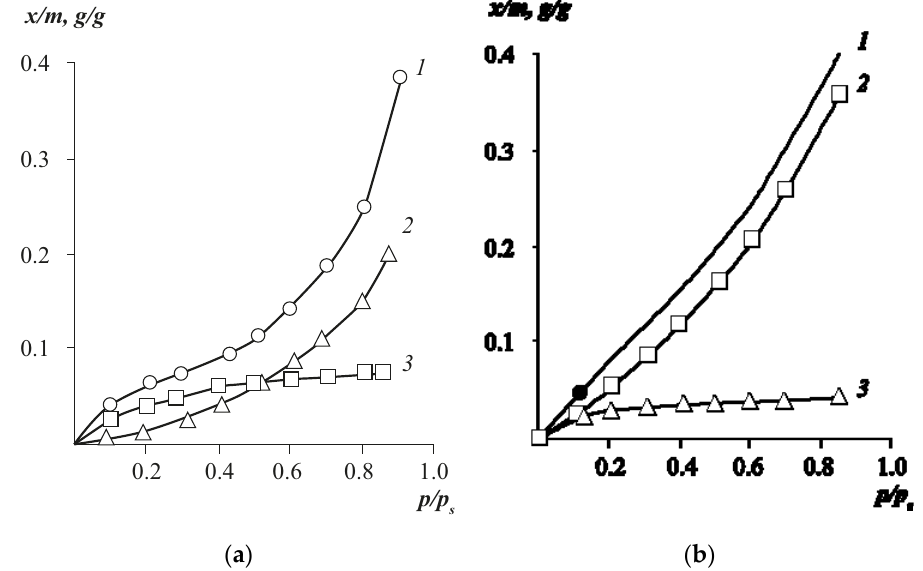
Figure 3. Decomposition of isotherms of water vapour sorption by cellulose hydrate at 20 ° С ( a ) and cellulose acetate (SD = 2.00) at 20 ° С ( b ) into components: 1—experimental isotherm, 2—Flory–Huggins isotherm, 3—Langmuir isotherm for ( a , b ).